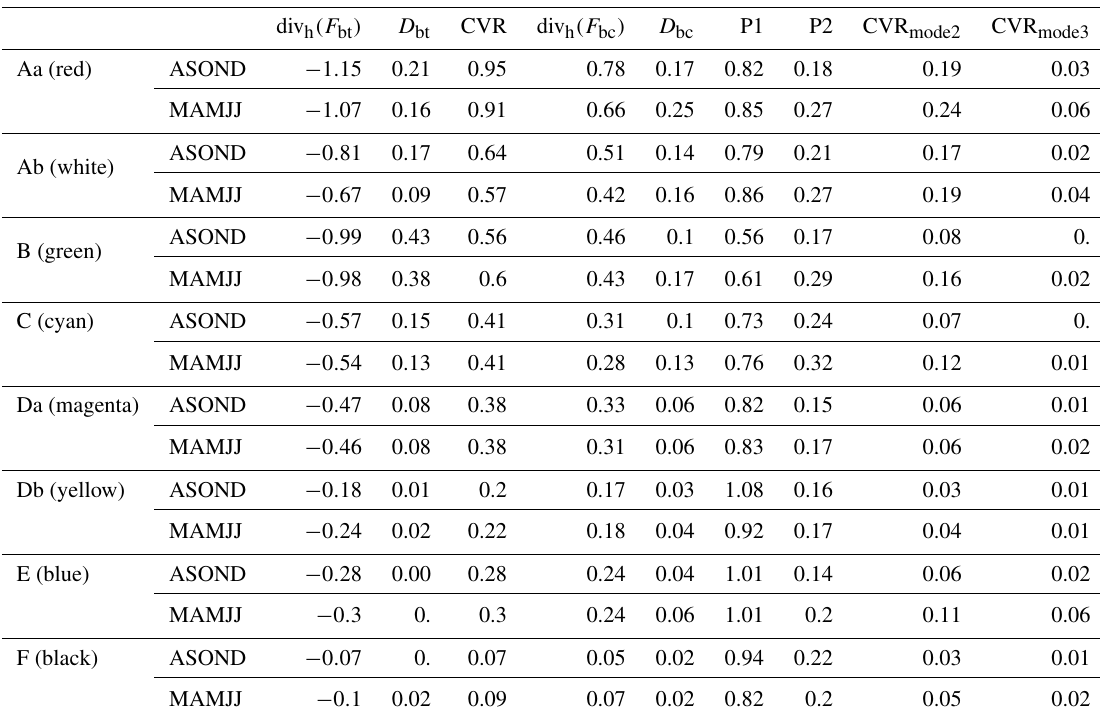
Table A2. Energy balance in the different boxes, units: GW. div h (F bt ) , D bt , CVR, div h (F bc ) , and D bc are integrated in the boxes. We masked on the shelf where bathymetry is less than 100m. P1 and P2 are defined by Eqs. (A1) and (A2),